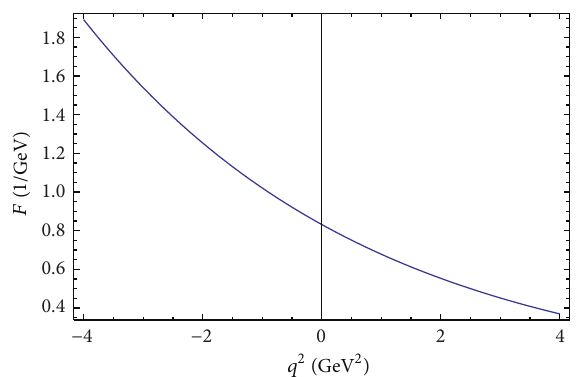
Figure5:Thedependenceofthefitfunction(23)andtheformfactor (22) on 𝑞 2 for values of 𝑠 0 = 14.5 , 𝑠 󸀠 0 = 12.25 , 𝑀 2 = 8 , and 𝑀 󸀠2 = 6 for the 𝜒 𝑐0 → 𝐽/𝜓𝛾 decays. The blue line is